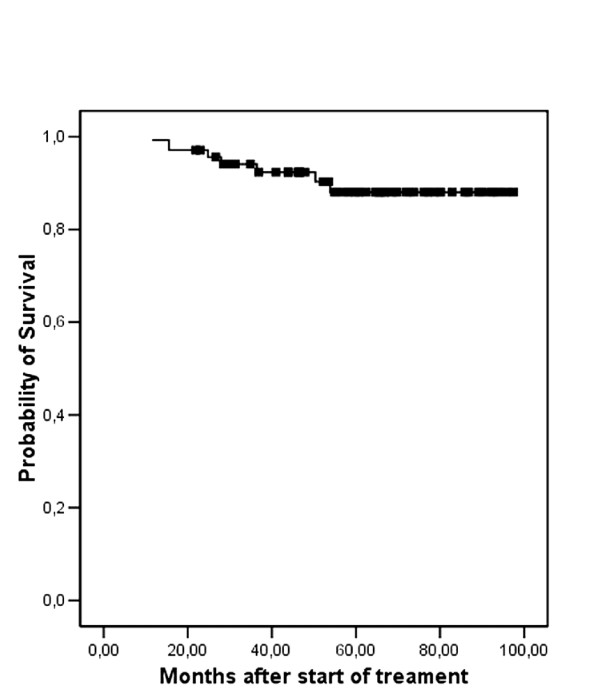
Overall survival of 69 patients treated with paclitaxel/carboplatin for early-stage (FIGO stages I-IIb) ovarian carcinoma.